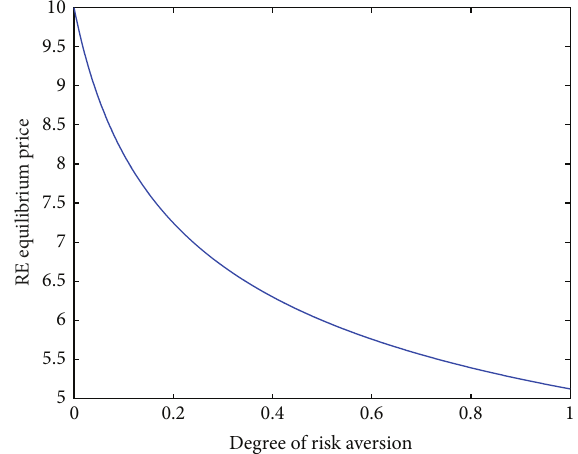
Figure 2: The effect of risk-averse level on 𝑝